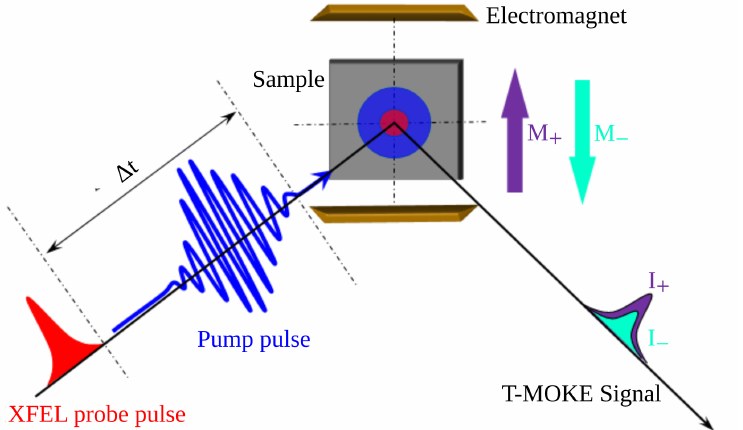
Figure 3. Time resolved T-MOKE configuration showing the probe (red) and pump (blue) beams, their footprints on the sample (red and blue spots) which is situated in the air gap of an electromagnet. The two opposite directions of magnetization ( M + and M − ) of the sample are represented (violet and cyan arrows) as well as the corresponding pulse intensities I + and I − (violet and cyan